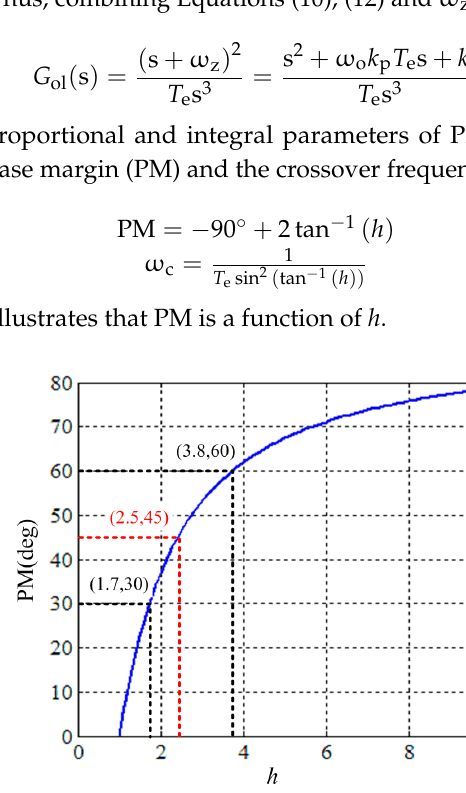
Figure 7. PM is a function of h .